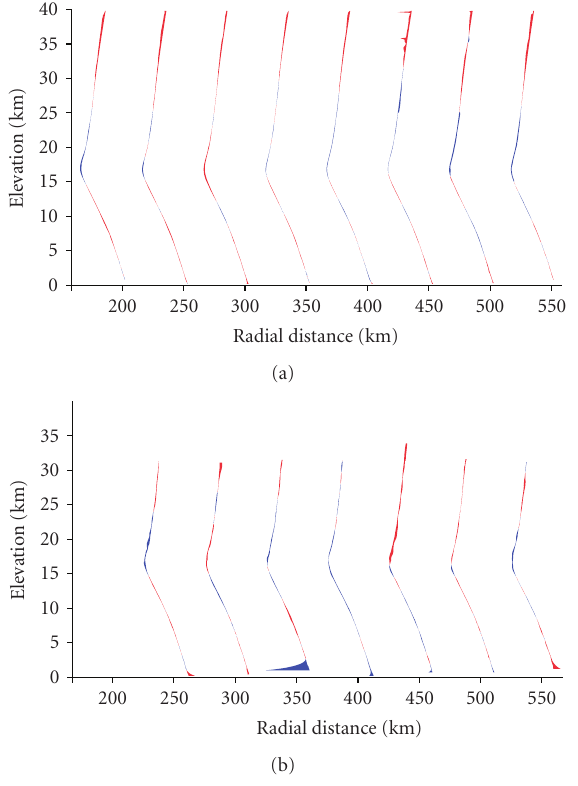
Figure 8: Same as Figure 7, but for Radial-interval mean inter- comparisons for GPS RO observations and (a) colocated global analysis, and (b) colocated radiosonde water vapor pressure (hPa). Elevations from the surface to 10-km are only considered due the lack of appreciable water vapor in the middle- to upper- troposphere. Red shading indicates where radial-interval mean vapor pressure is less than the colocated profiles while the green shading indicates where the observation vapor pressure is greater than the colocated